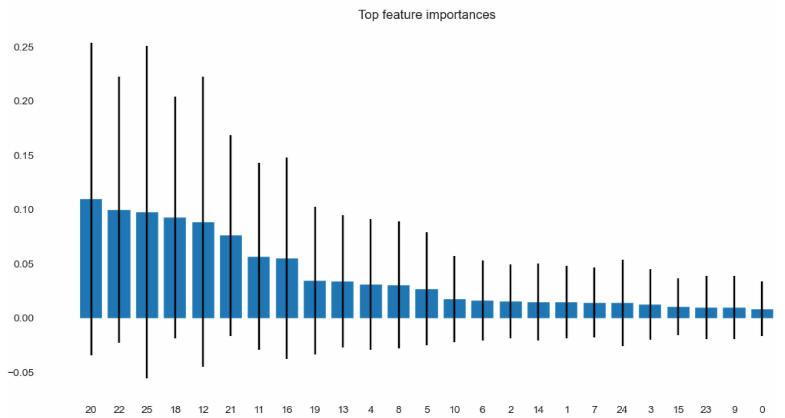
Figure 3. Feature importance of the